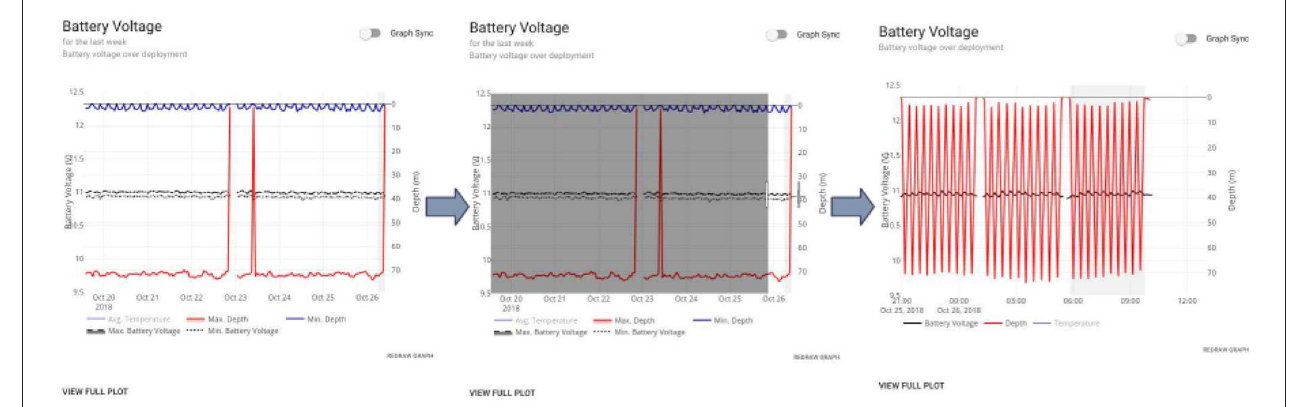
FIGURE 7 | Succession of screenshots of the interactive plots, illustrating the retrieval and display of higher-resolution data upon